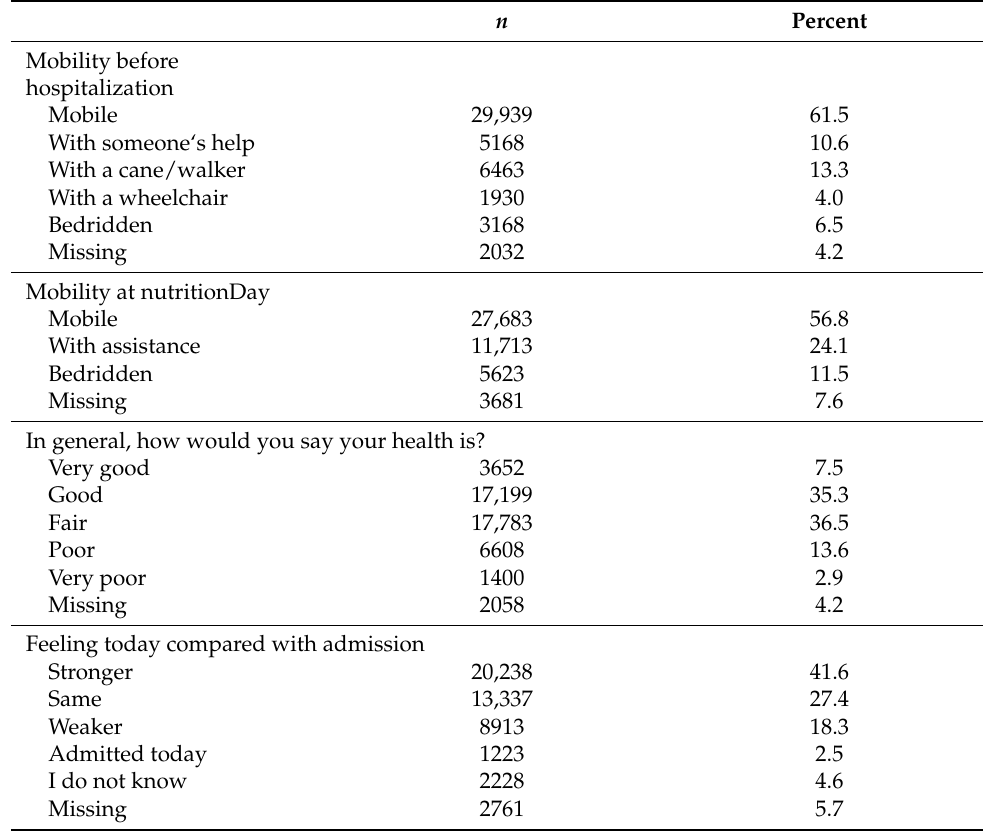
Table 3. Mobility before admission and at nutritionDay as well as the self-reported health status and evolution during hospitalization ( n =